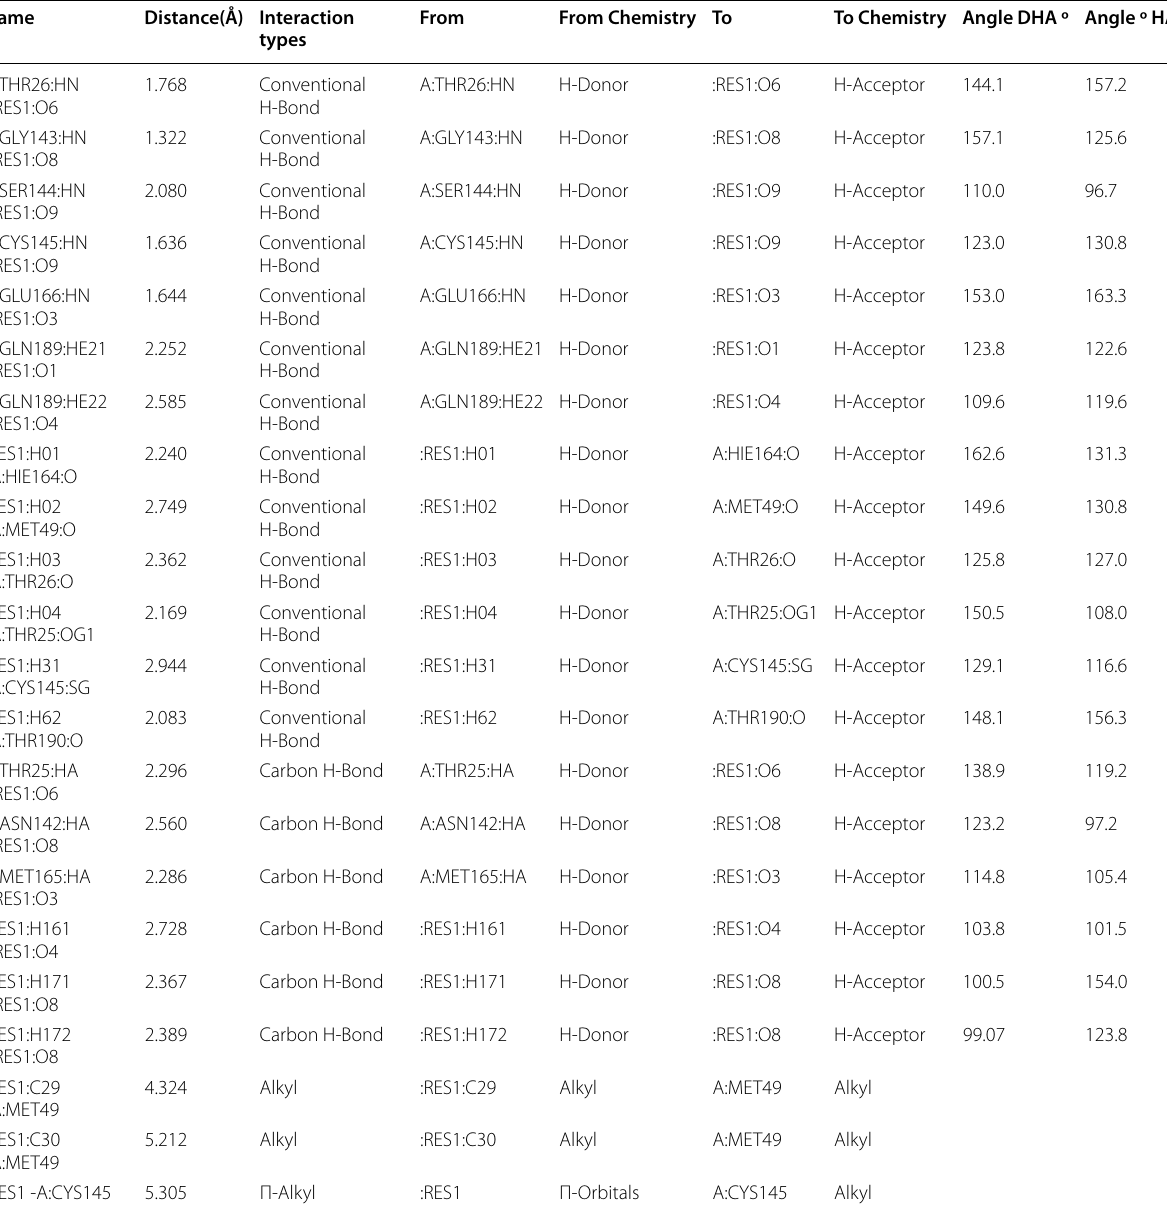
Table 11 Interaction types of surrounding amino acids of SARS CoV 2 Main Protease (PDB ID: 6XBH) with inhibitor with Index number 847b Name Distance(Å) Interaction From From Chemistry types